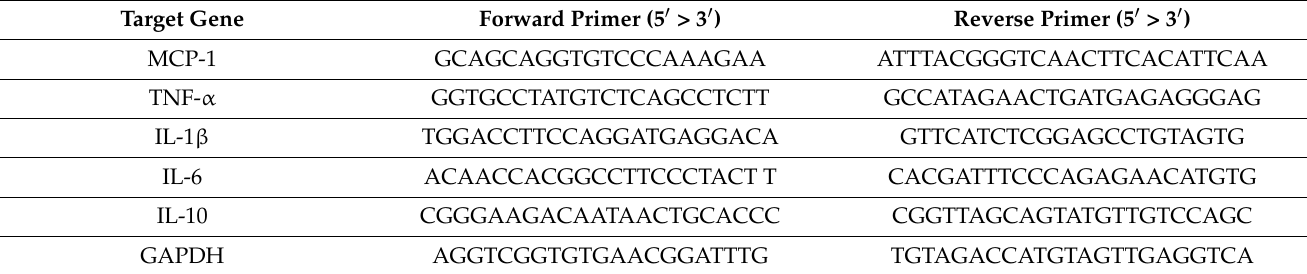
Table 1. Primer sequences for cytokines tested in